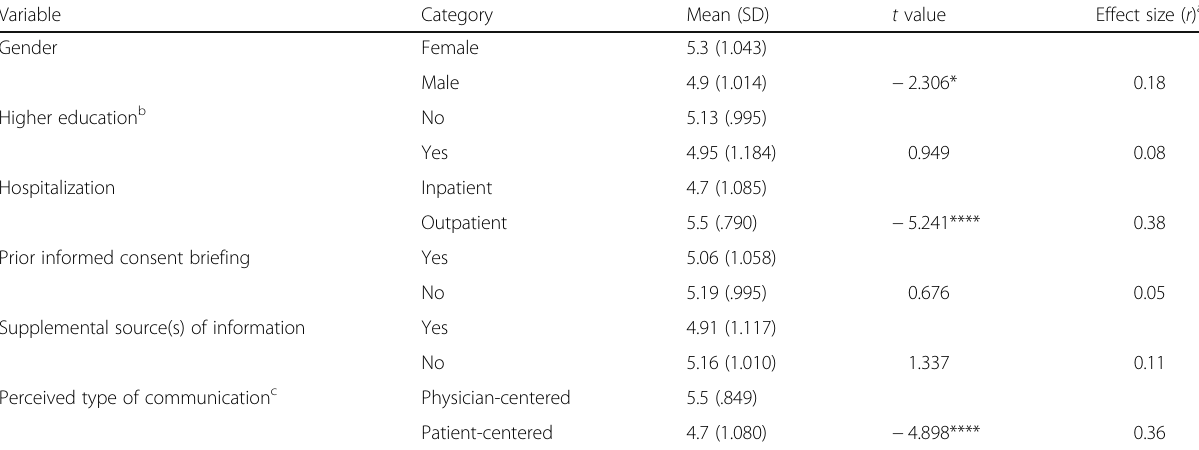
Table 2 Statistical analysis of patient